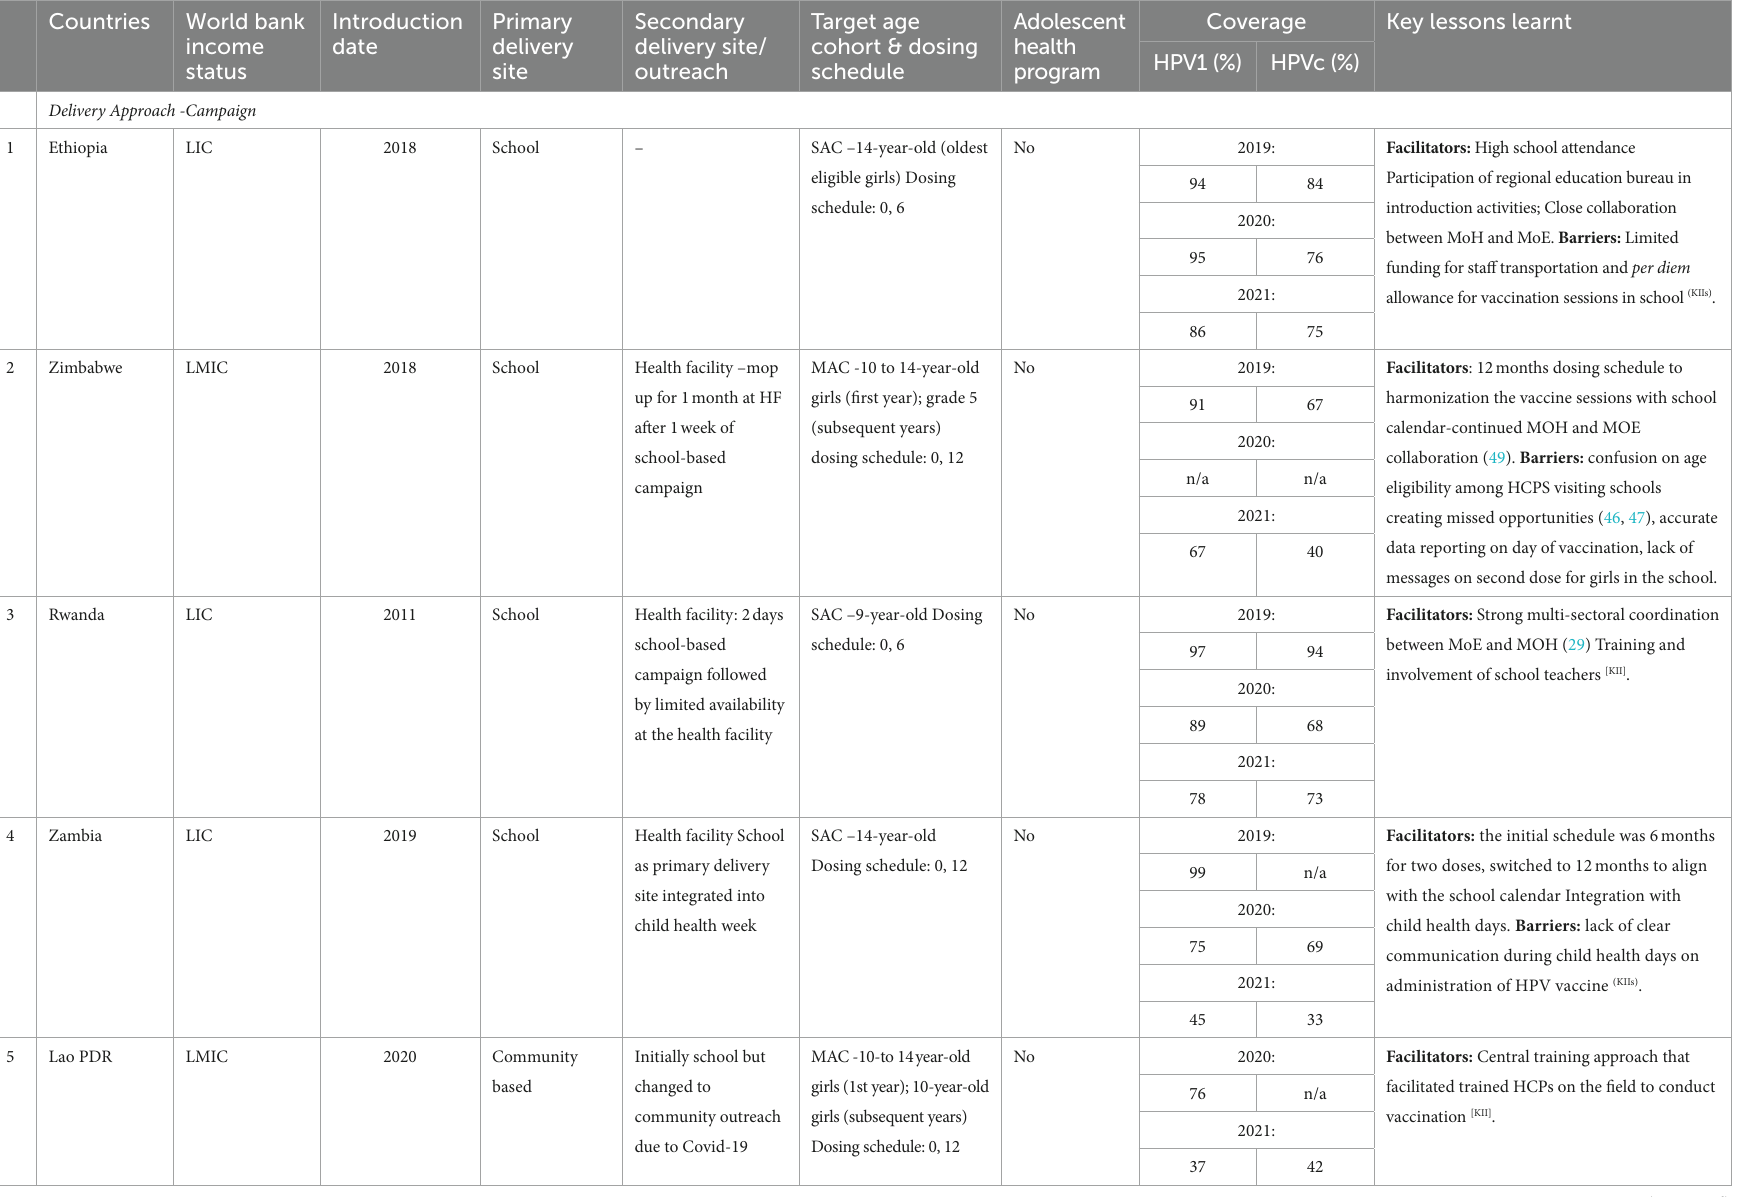
TABLE 2 Barriers and facilitators related to HPV vaccine delivery. The table includes barriers and facilitators related to HPV vaccine delivery including cross-cutting themes such as microplanning, communication and social mobilization.